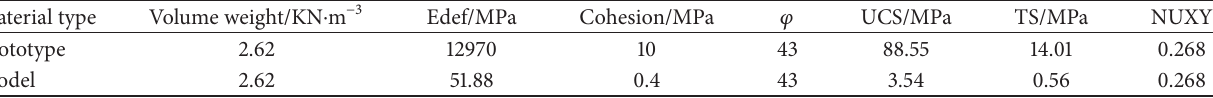
Table 1: Physical-mechanical parameters of the prototype rock and model material.